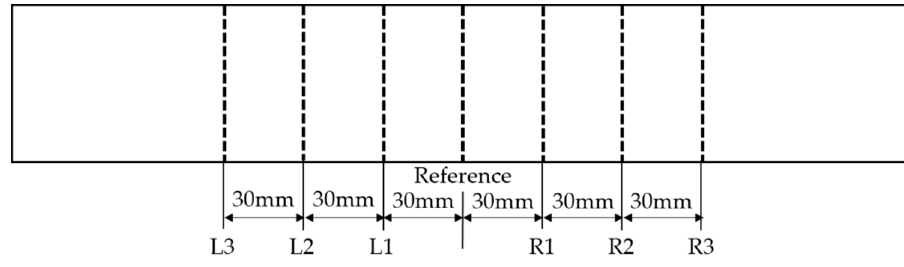
Figure 5. Measurement points of the specimen.